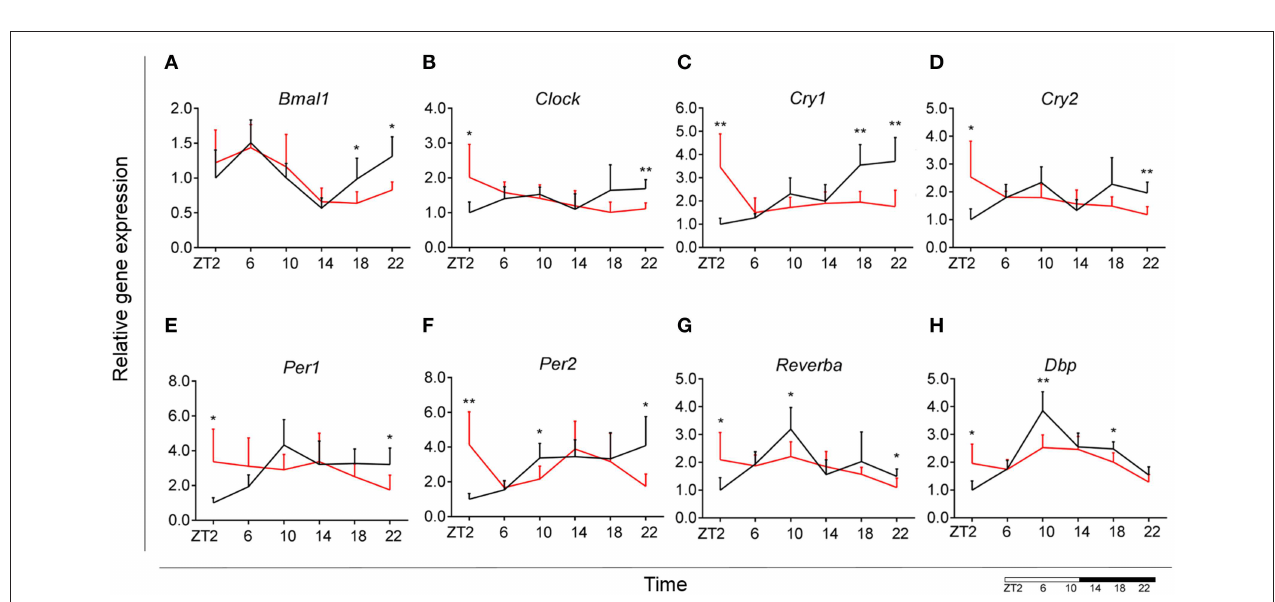
FIGURE 2 | HFD intake leads to obesity in rats. HFD (orange) leads to an increase in food intake (A) ( p int < 0.0001, p time < 0.0001, p diet < 0.0001), body weight (B) ( p int < 0.0001, p time < 0.0001, p diet = 0.0003), and fat mass gain, seen as 2-fold increase in perirenal white adipose tissue (C) in rats, compared to chow-fed controls (black). Plasma measurements in non-fasted HFD-fed animals show an increase in glucose at ZT6 (D) ( p int = 0.0032, p time = 0.0003, p diet = 0.0874), increased insulin at ZT18 (E) ( p int = 0.2802, p time = 0.0042, p diet = 0.0006), and significant increase in non-esterified fatty acids during the light phase (F) ( p int < 0.0001, p time = 0.0006, p diet < 0.0001). Data are presented as means ± SEM. Statistical significance was determined using Two-way ANOVA (A,B,D–F) or unpaired t -test (C) . Effect of diet within each time point was evaluated with Sidak’s multiple comparison test (A,B,D–F) (* p < 0.05; ** p < 0.01, *** p < 0.001, **** p < 0.0001).